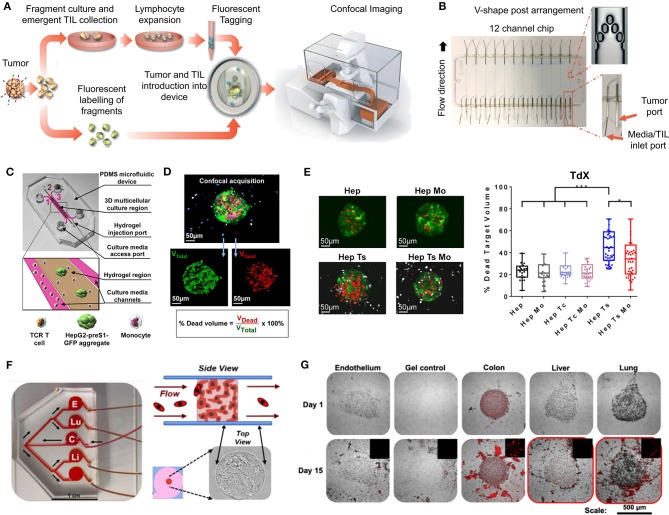
Tumor-on-chip systems. (A) Diagram illustrating the processing steps involved in the preparation of patient-derived tumor cells and tumor-infiltrating lymphocytes (TILs) from the same tumor sample, and live imaging by confocal microscope. (B) 12-channel multiplexed cyclic-olefin-copolymer (COC)-based microfluidic device with V-trap design for capturing tumor sample in flow stream and dual port entry for TILs. (C) A 3D multicellular tumor microenvironment microfluidic model consisting of a middle hydrogel channel (2) surrounded by two media channels (1, 3) for the mechanistic study of the effect of monocytes on T cell receptor-redirected T cell (TCR T cell) killing of tumor cell aggregates. Human monocytes were inserted together with target HepG2-preS1-GFP cell organoids in collagen gel in the central hydrogel region (2), while hepatitis B virus (HBV)-specific TCR T cells were added into one fluidic channel (1) to mimic the intrahepatic carcinoma environment. (D) Representative confocal image of a target cell organoid (in green) surrounded by monocytes (in blue) and HBV-specific TCR T cells (in white), in which the presence of dead target cells is DRAQ7+. (E) Left: Representative target cell HepG2 cell organoids (Hep) cultured with monocytes (Mo) and/or HBV-specific T cell (Ts), in which the presence of dead target cells is DRAQ7+(in red). HBV-specific TCR T cells are labeled with Cell tracker violet dye (in white), while monocytes are unlabeled. Right: Box plot of the percentage of dead target volume after 24 h of co-culture with retrovirally transduced (Tdx) HBV-specific TCR T cells (Tc = control T cell). (F) Metastasis-on-a-chip device and in situ tumor and tissue construct biofabrication. Arrows show fluid flow (E, endothelium; Lu, Lung; C, colorectal cancer organoids made of RFP tagged HCT116 cells; Li, liver; blank, control). Constructs comprised of cells in ECM hydrogels exist under fluid flow and have the capability to experience circulating cells either interact or pass by. (G) Metastasis tracking at day 1 and day 15 showing HCT116 cells colonizing other organs, using phase and epifluorescence microscopy (A–G) reproduced with permission from Lee et al. (2018), Moore et al. (2018), and Aleman and Skardal (2019), respectively. *P ≤ 0.05, ***P ≤ 0.001.